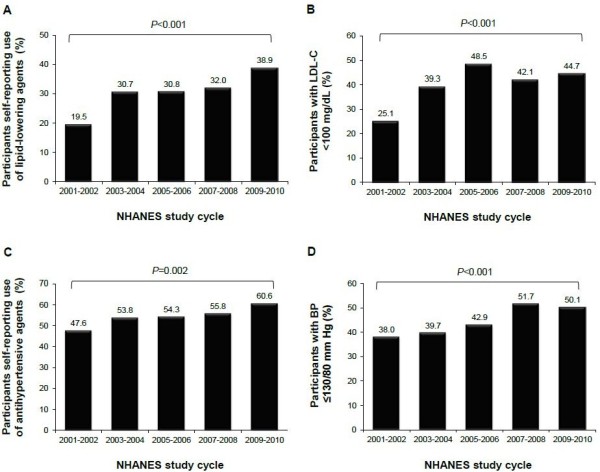
Time-trend analysis of lipid and BP treatment and control rates in US adults ≥20 years of age with CKD Stage 1–4 based on 2001–2010 NHANES participants. A) Proportion of persons with CKD with self-reported use of lipid-lowering agents. B) Proportion of persons with CKD at LDL-C goal <100 mg/dL. C) Proportion of persons with CKD with self-reported use of antihypertensive agents. D) Proportion of persons with CKD at BP goal ≤130/80 mmHg. P values are for trend over time, obtained using the SAS procedure SURVEYLOGISTIC (see Methods).